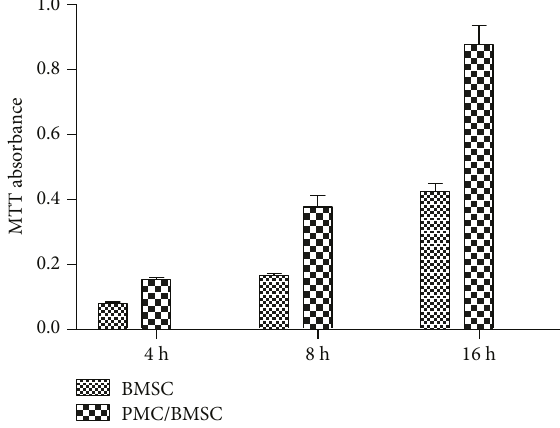
Figure 3: PCMs promote growth of